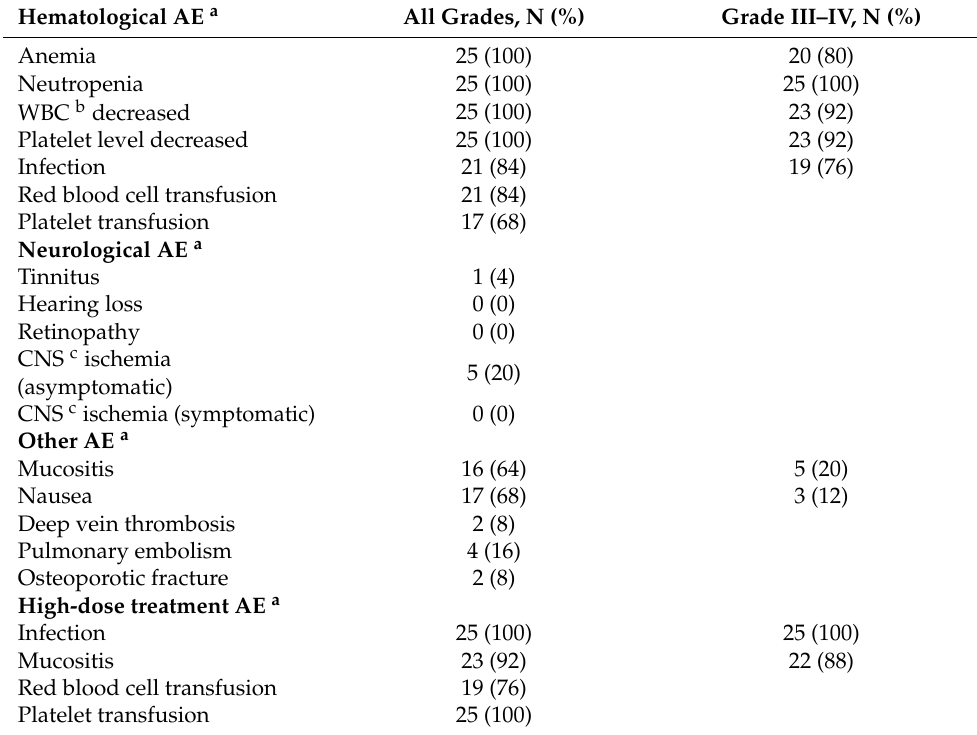
Table 4. Frequency of hematological, neurological or other adverse events of the blood–brain barrier disruption treatment and toxicities from the autologous stem cell transplantation-supported high- dose